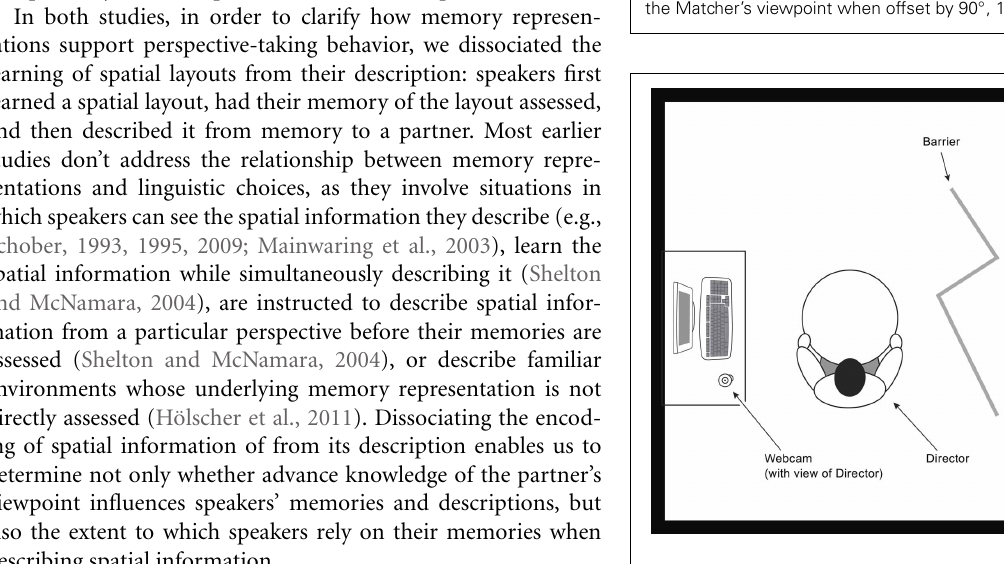
would occupy at the description phase. The degree of misalign- ment between partners during the description phase, was 90 ◦ , 135 ◦ , or 180 ◦ , and was counterbalanced across the three